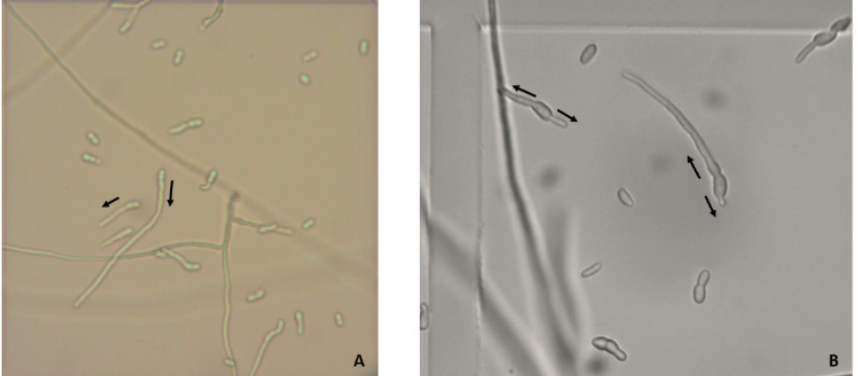
Figure 4. Multiple germination tubes on spores in microgravity. Multiple germination tubes observed using optic microscopy on spores of the CBS 124889 strain obtained 1 g control ( A ) or under simulated microgravity ( B ) at 48 h (arrow to visualize the direction of germination) (×200).